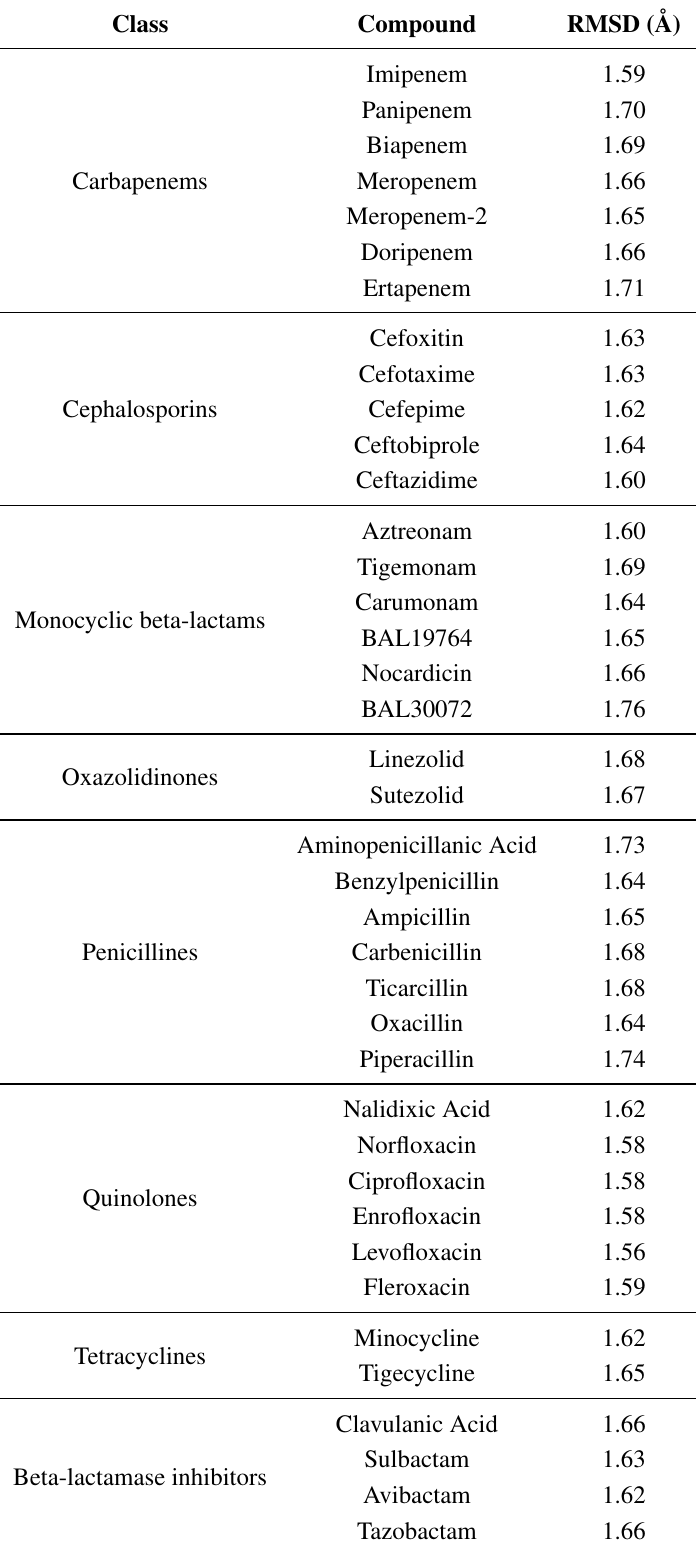
Table A2. Root-mean-square displacement between the B3LYP/6-31G (cid:63)(cid:63) optimized geometry and the minimum-energy structure obtained with the GAFF parameters of the